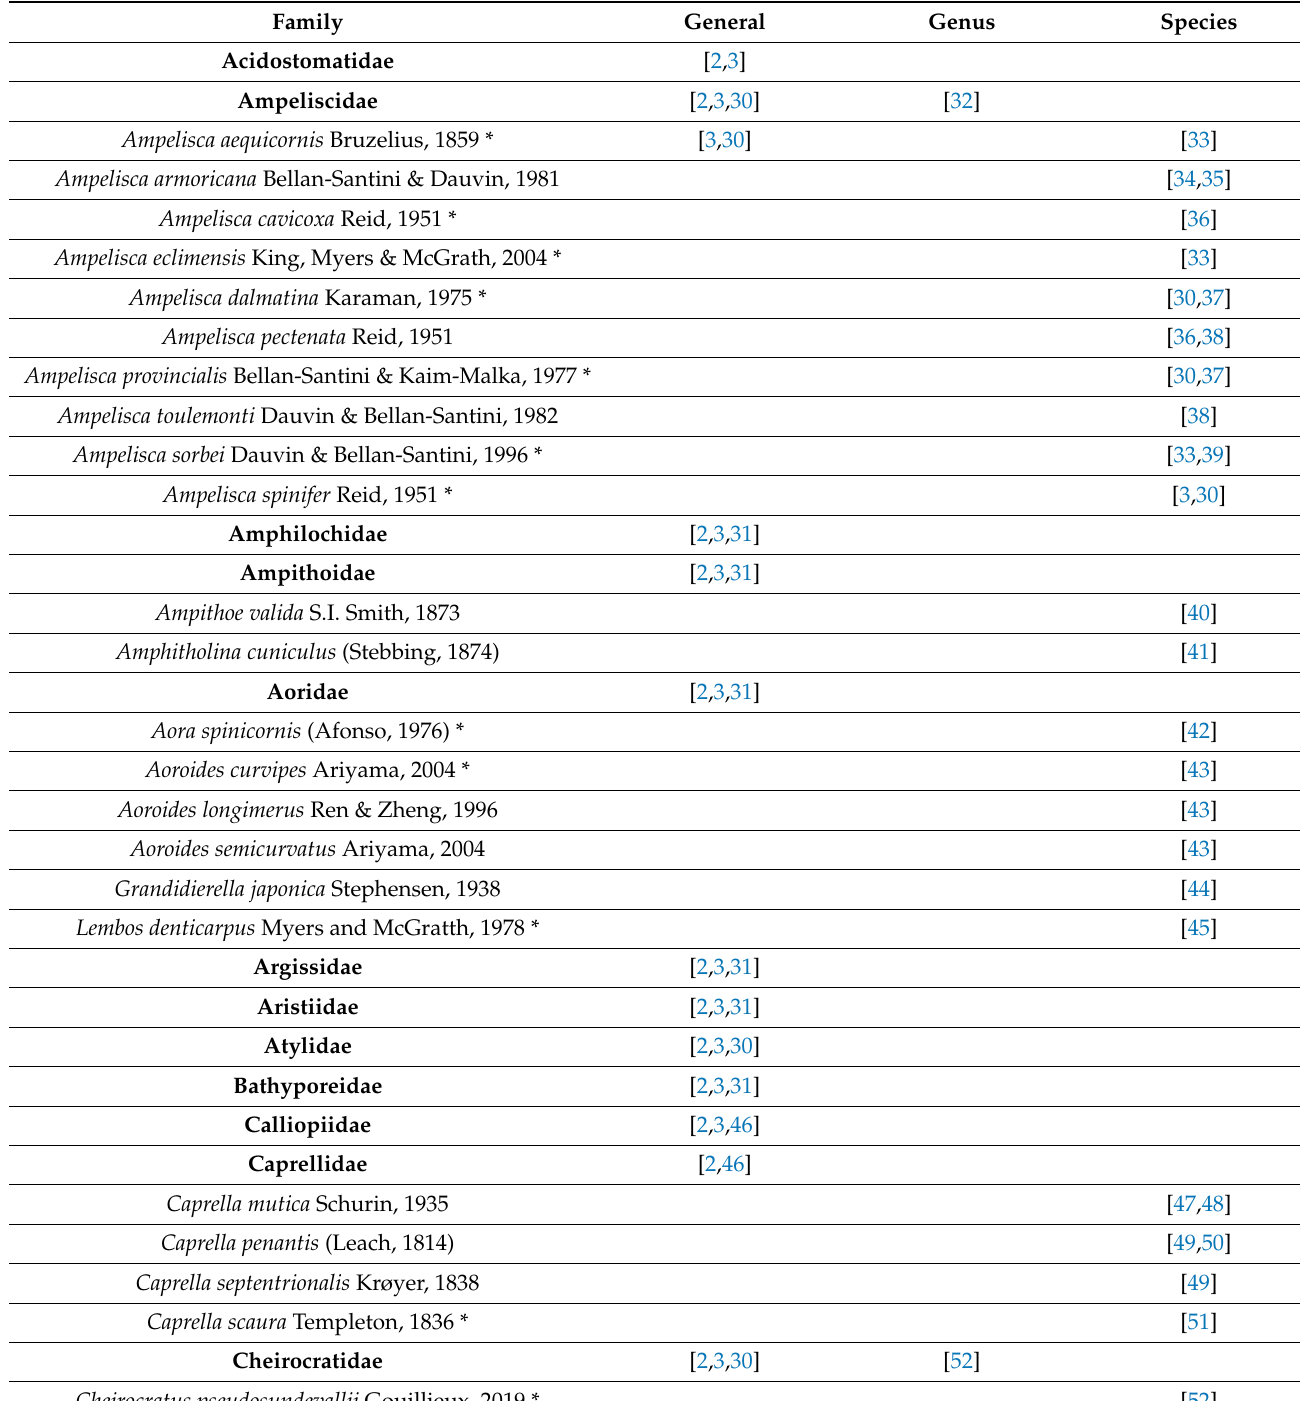
Table 1. Guide of fauna and publications used to identify amphipods recorded in the English Channel and other probable species (found in neighbouring zones in sediment types and depths occurring in the English Channel). 1: [2]; 2: [3]; 3: [29]; 4: [30] and 5: [31]. Column Genus: list of references useful to identify the genus; column Species: list of references useful to identify the species. * Not recorded for the moment in the English